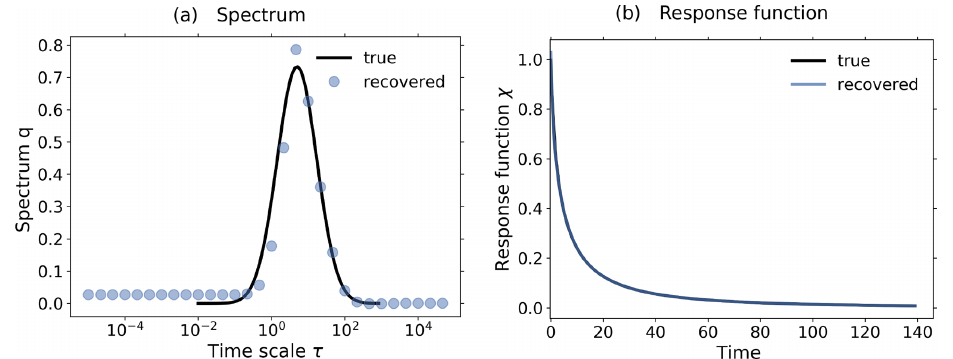
Figure E10. Response function χ(t) and spectrum q λ recovered from toy model data taking the RFI parameters M = 30, log τ min = − 5, and log τ max = 5. Blue dots in (a) and blue line in (b) indicate the recovered values for the spectrum and for the response function, while black lines indicate their “true” values.